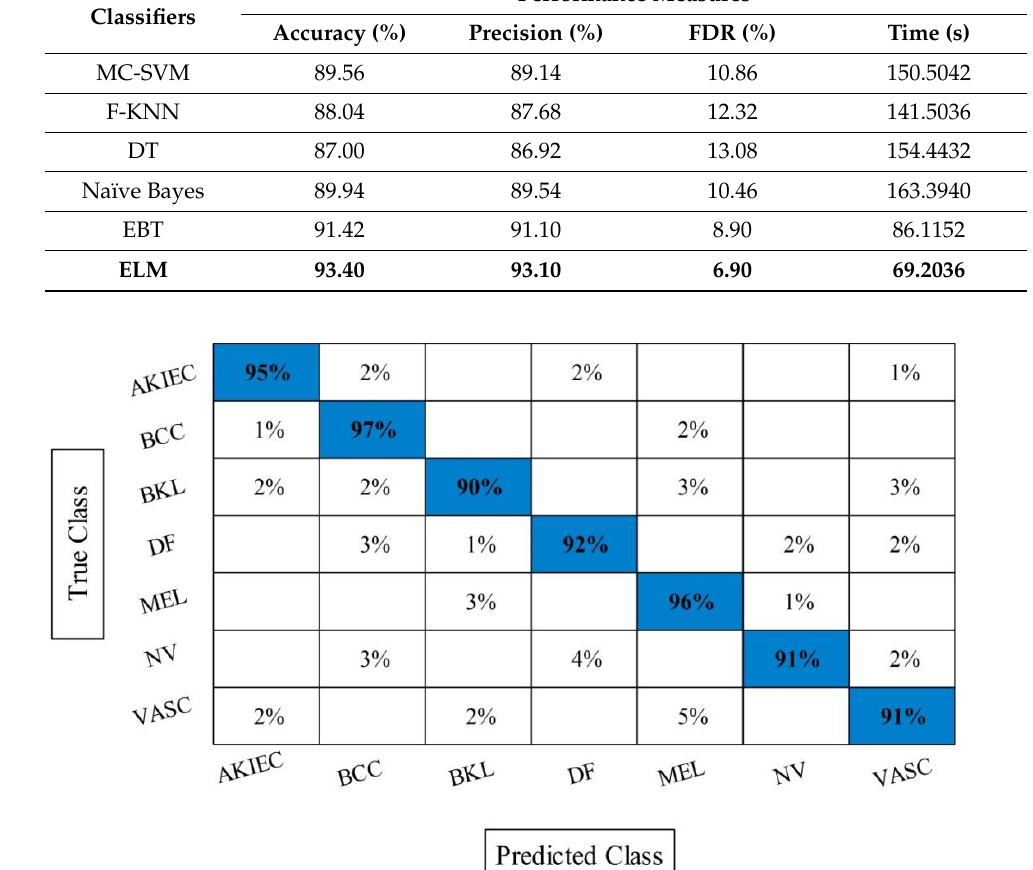
Table 4. Classification accuracy using selected features fusion approach for HAM10000 dataset.